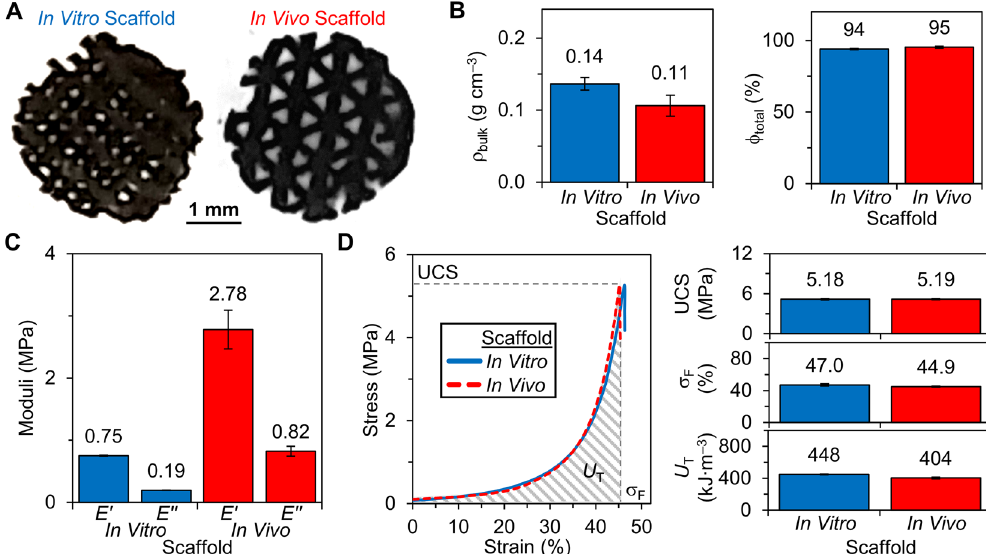
Figure 2. Bulk and mechanical properties of 3D printed CaPG matrices for in vitro and in vivo use. (A) Images of the in vitro and in vivo matrices. (B) The bulk density (ρ bulk ) and total porosity (ϕ total ) of matrices. (C) The compressive storage ( E’ ) and loss ( E’’ ) moduli of matrices. (D) The stress–strain curves and their quantified parameters: ultimate compressive strength (UCS), strain at failure (σ F ), and toughness ( U T ) of matrices. Note that bars in ( B–D ) are the average of n = 3 measurements, and error bars are standard